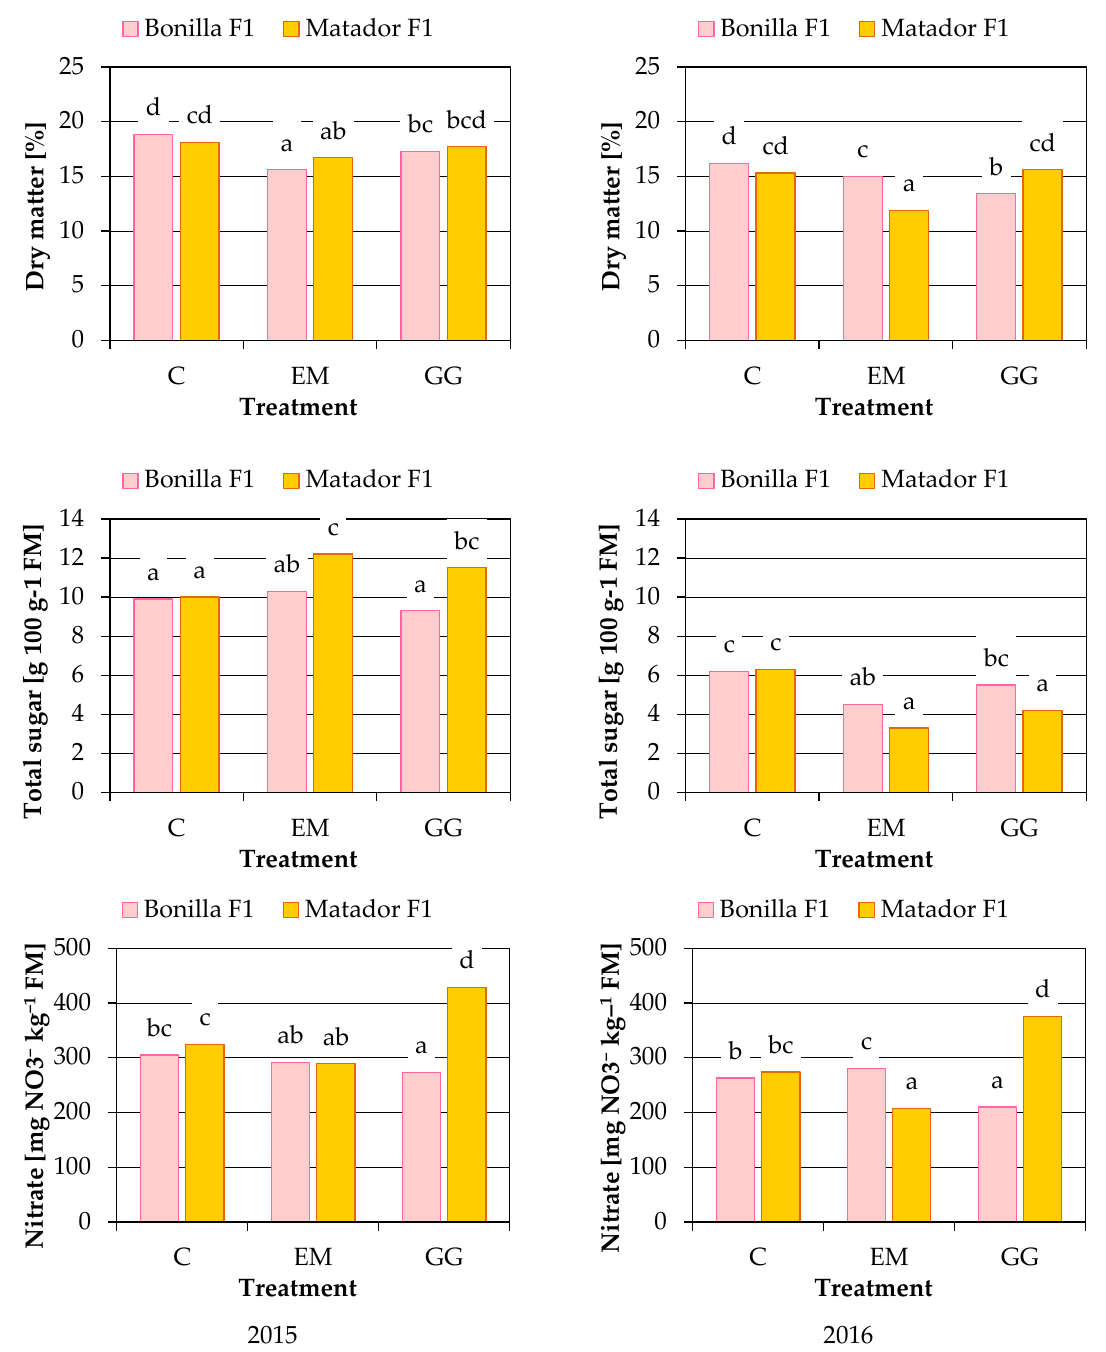
Figure 3. Chemical composition of shallot bulbs. Means followed by different letters are significantly different for each parameter. C—control treatment, EM—1% solution of Effective Microorganisms, GG—0.1% solution of Goëmar Goteo.